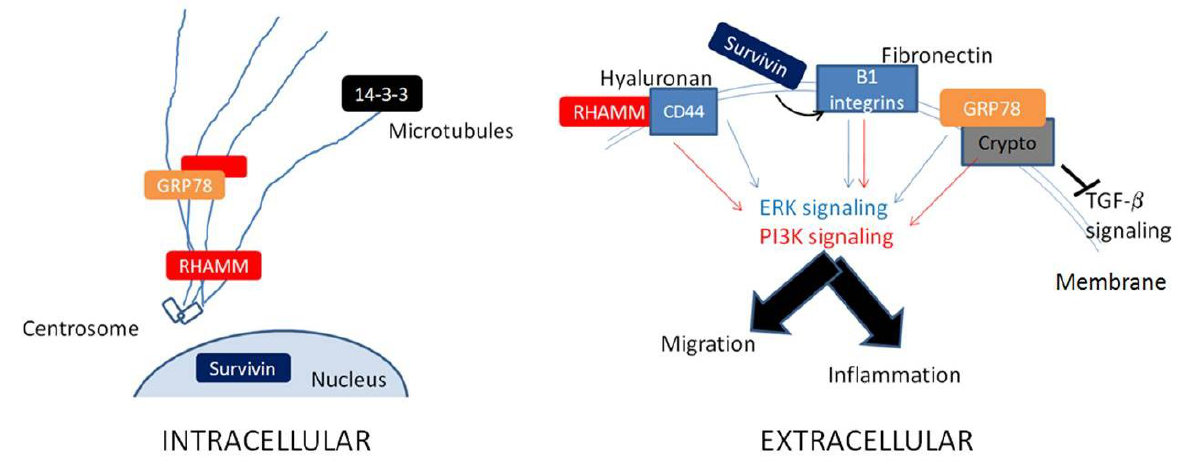
FIGURE 1. Cytoskeleton on the inside, coreceptor on the outside. Many cytoskeletal and nuclear proteins function as coreceptors within degenerative disease, such as cancer and arthritis. Frequently, these secreted proteins influence signaling through ERK, PI3K, and NF-kB (not shown) with downstream consequences on cell migration and